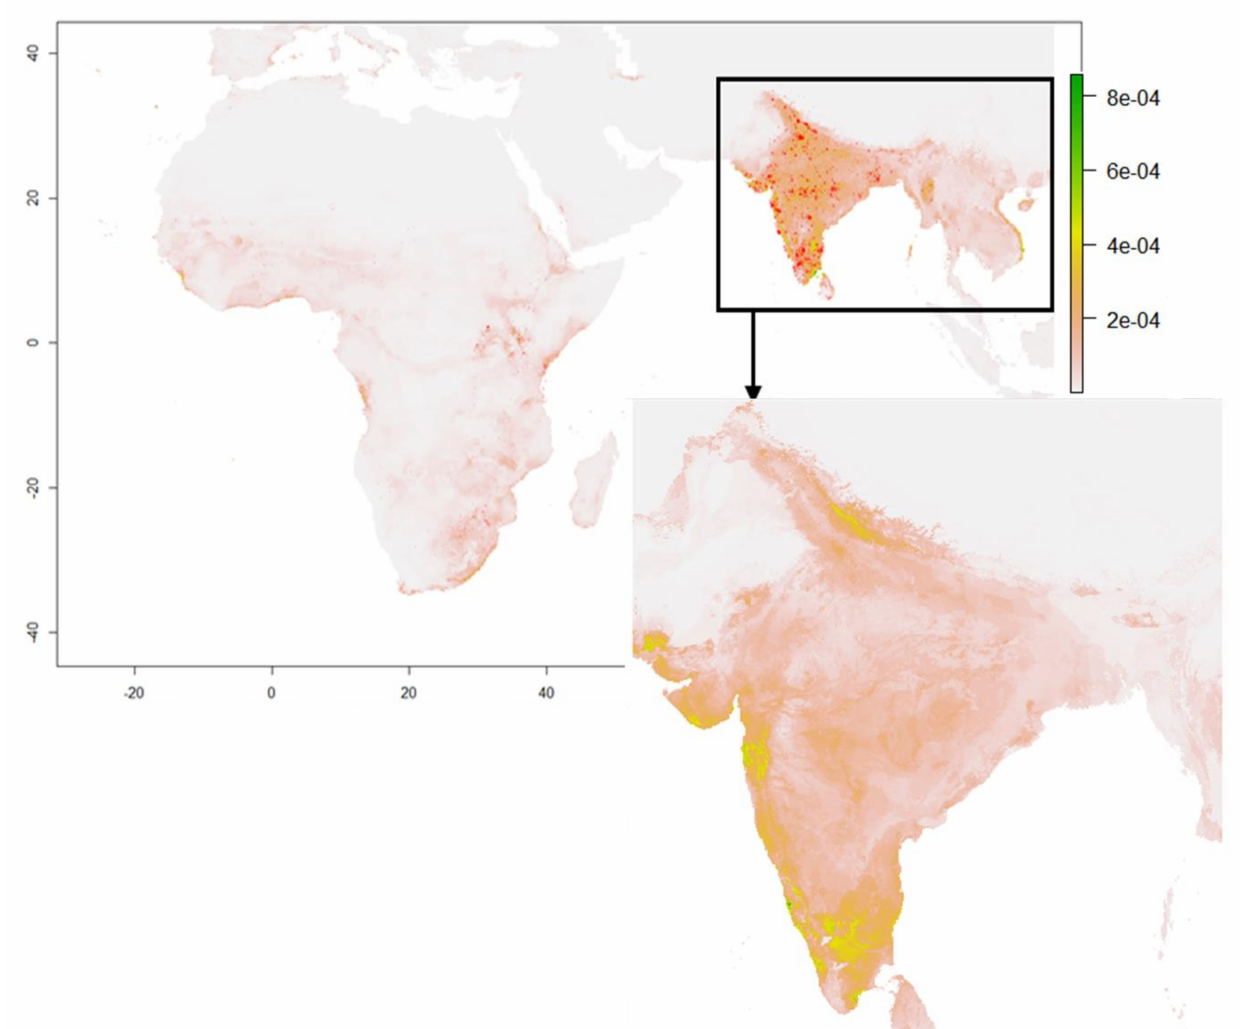
Figure 3. Habitat suitability prediction of June-September for the Pied cuckoo